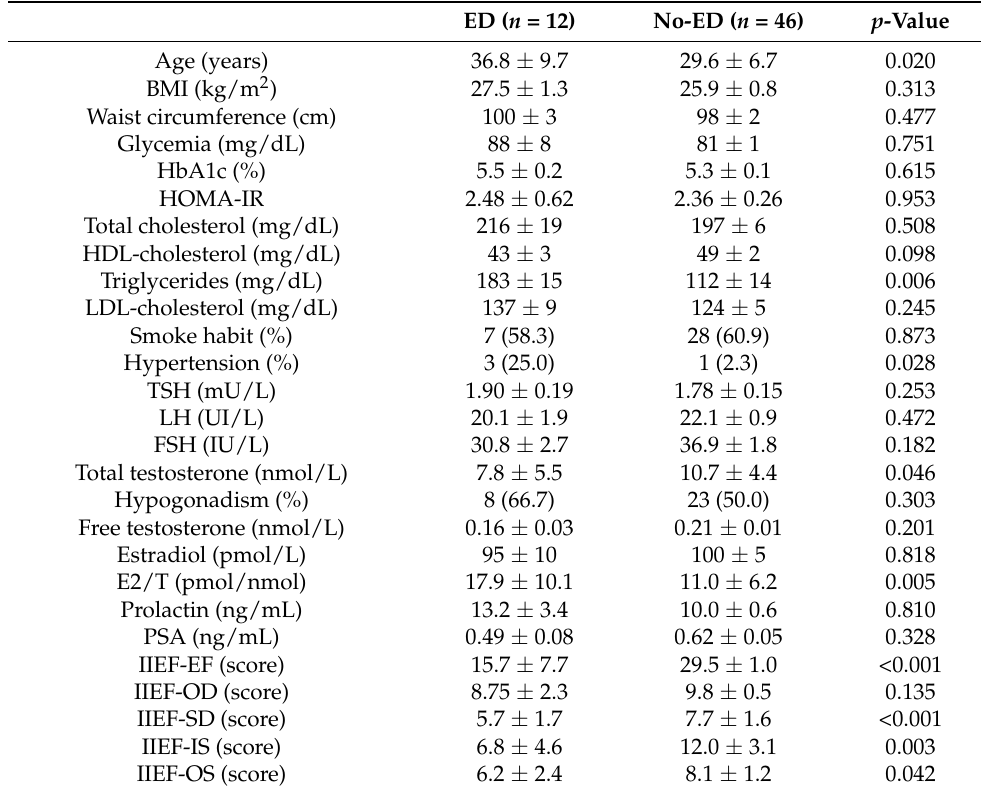
Table 2. Comparison between patients with ED and without ED.